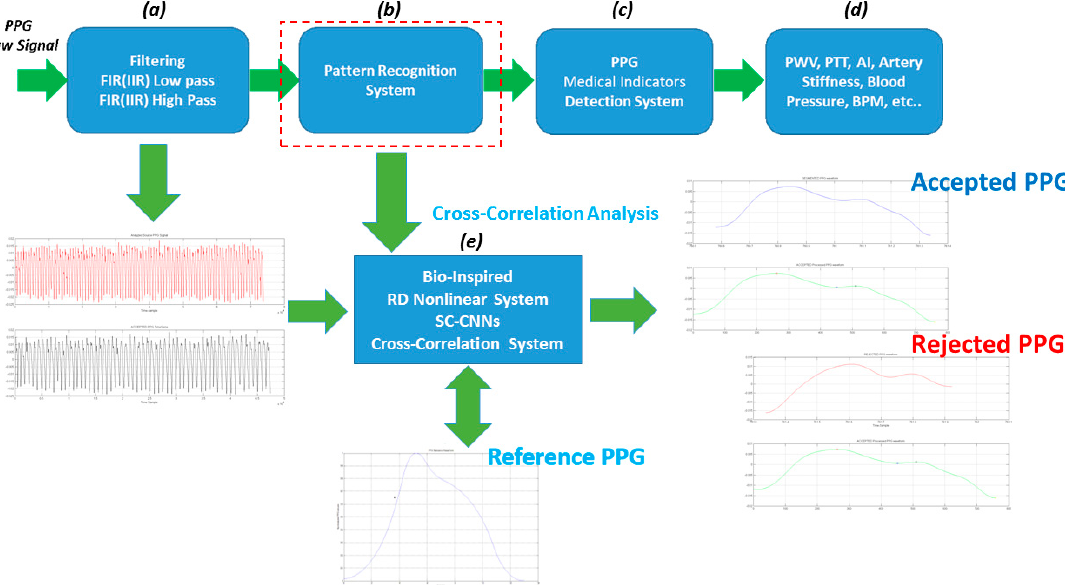
Figure 10. Detailed description of the whole PPG Pipeline (blocks ( a – d )) with description of hw pipeline developed for signal acquisition with NI device (Data filtering, derivative analysis of acquired PPG signal, GUI and data visualization stage of the acquired physiological data). 4. EEG Physiological Analysis and Recognition Electrocardiography (ECG) is the process of recording the electrical activity of the heart over a period of time using electrodes placed on the skin. These electrodes detect the tiny electrical changes on the skin arising from electrophysiological patterns of de-polarization and re-polarization which occurs during each heartbeat of the heart muscle. Electrocardiography is a cardiology test commonly performed. A typical ECG waveform includes two intervals: (a) PR interval including both P